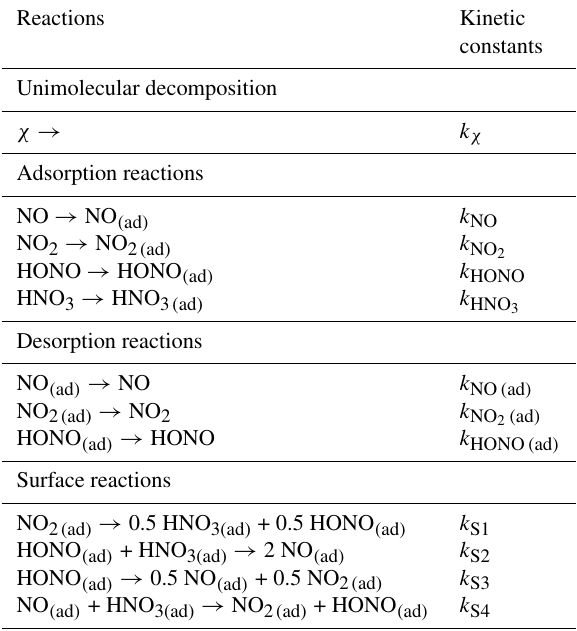
Table 1. Heterogeneous reactions added to the RACM2 model. The symbol χ designates the species that undergo unimolecular de- composition. These species are O 3 , NO 3 , HNO 4 and H 2 O 2 . Re- actions (S 1 ), (S 2 ), (S 3 ) and (S 4 ) (surface reactions) are the model equivalent of Reactions (R1), (R3), (R2) and (R4),